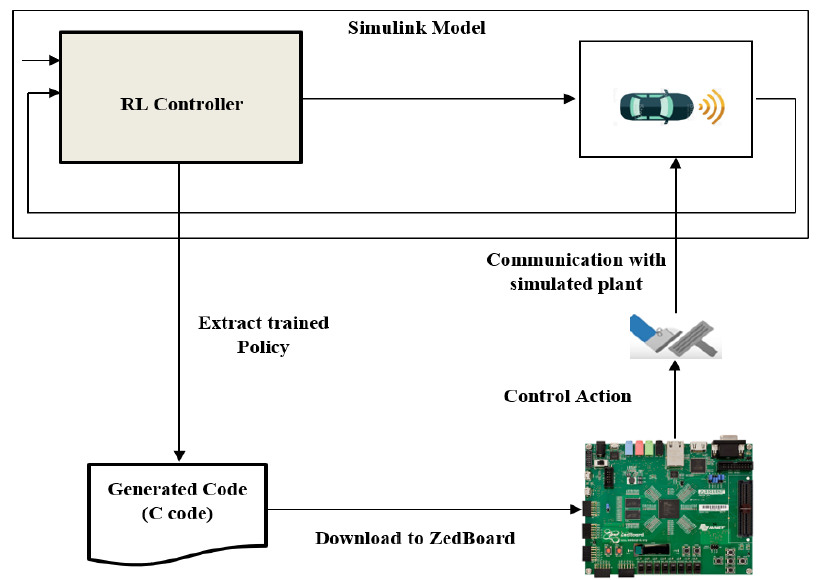
Figure 13. Overall diagram of running the RL model on